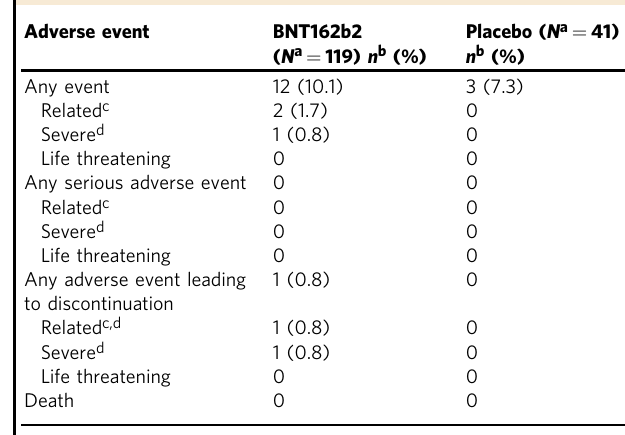
Table 2 Participants reporting at least 1 adverse event from dose 1 through 1 month after dose